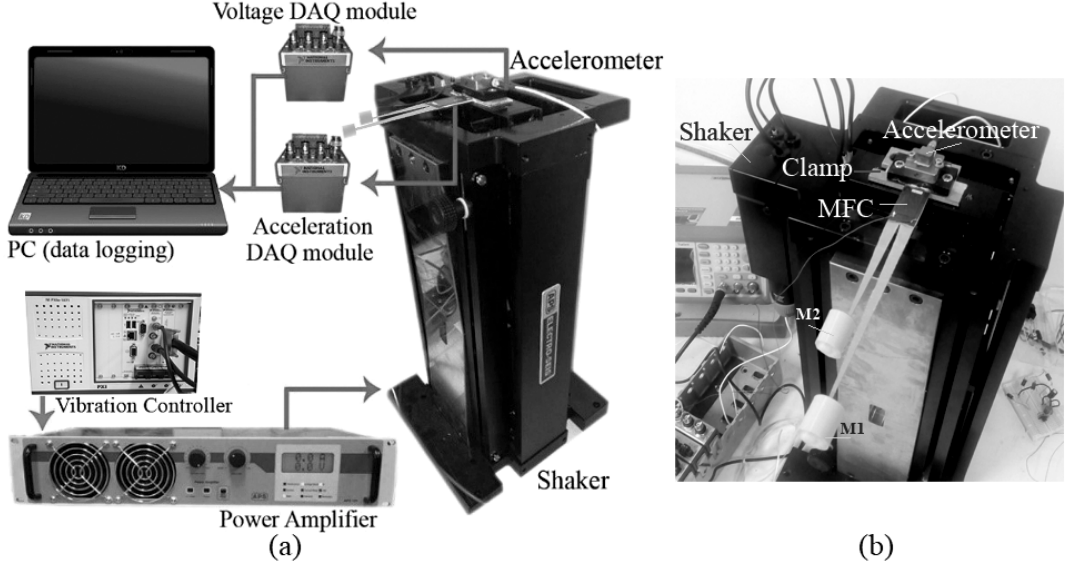
Figure 6. Schematic of ( a ) the experimental setup and ( b ) the fabricated MRPEH prototype attached on the shaker.